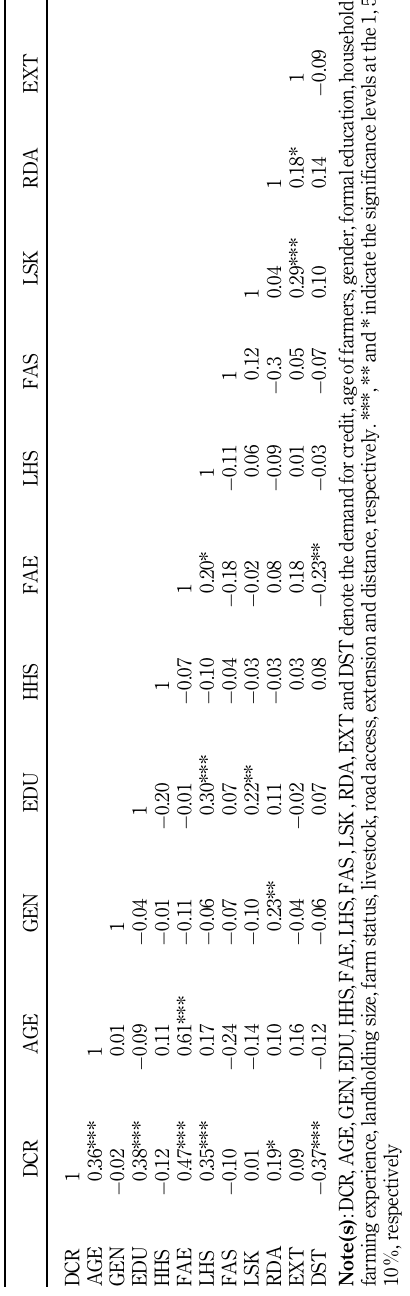
Table 2. Results of correlation